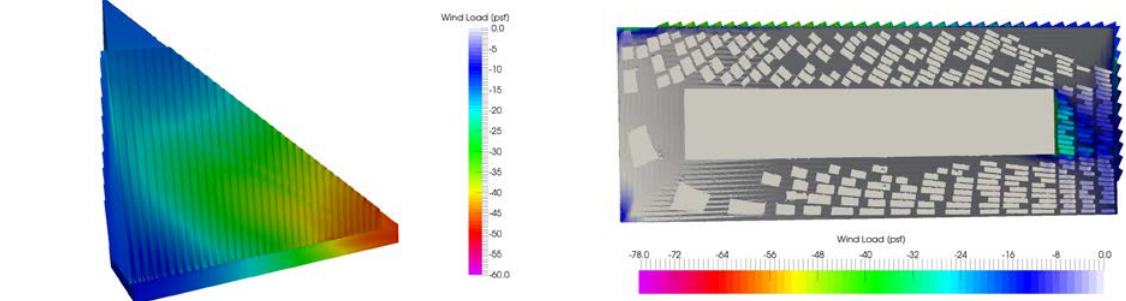
Fig. 9 3D fringe plots indicate negative pressure loads calculated from a single wind